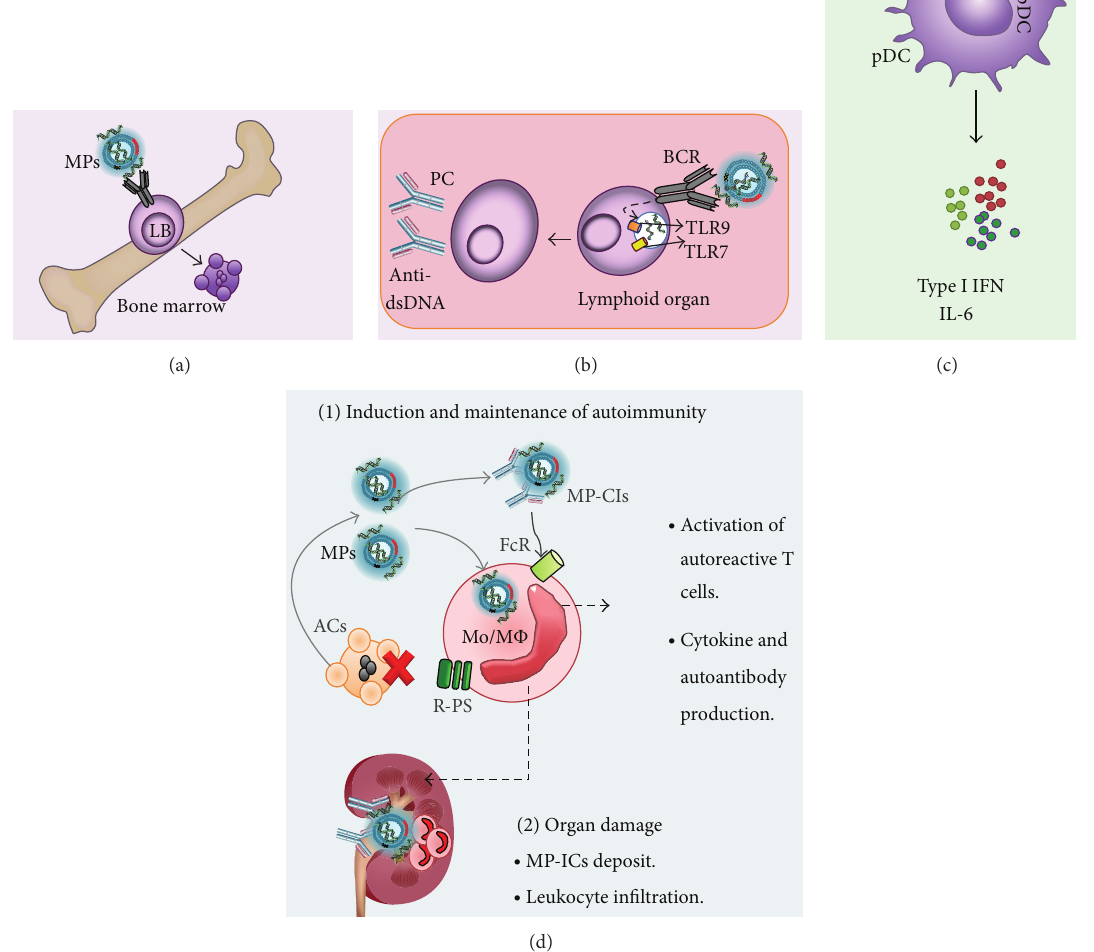
Figure 3: Role of MPs in SLE. MPs can interact with B cells (LB) (a) during ontogeny-induced apoptosis (clonal deletion), secondary rearrangement, or BCR edition in cells whose BCRs recognize DNA with high affinity. (b) At the lymphoid organ level, MPs can also bind to an autoreactive BCR and induce anergy of LB or alternatively be endocytosed by these cells and induce a second signal through TLR9 and TLR7 by the DNA and RNA present on these structures. These recognition activate and differentiate B cells into plasma cells able to produce autoantibodies. (c) MPs can be internalized by plasmacytoid dendritic cells (pDCs) and through the recognition of nucleic acids produce type I IFNs and other cytokines such as IL-6. (d) MPs might compete with ACs to bind PS receptors on monocytes and macrophages (Mo/M Φ ), which seem to contribute to the lower uptake of ACs observed in these patients. In addition, MPs can be a major source of autoantigens in SLE with the consequent generation of ICs; all this could eventually (1) produce and maintain the inflammatory immune response and (2) promote the damage of different tissues and organs in patients with SLE due to the exacerbated inflammatory